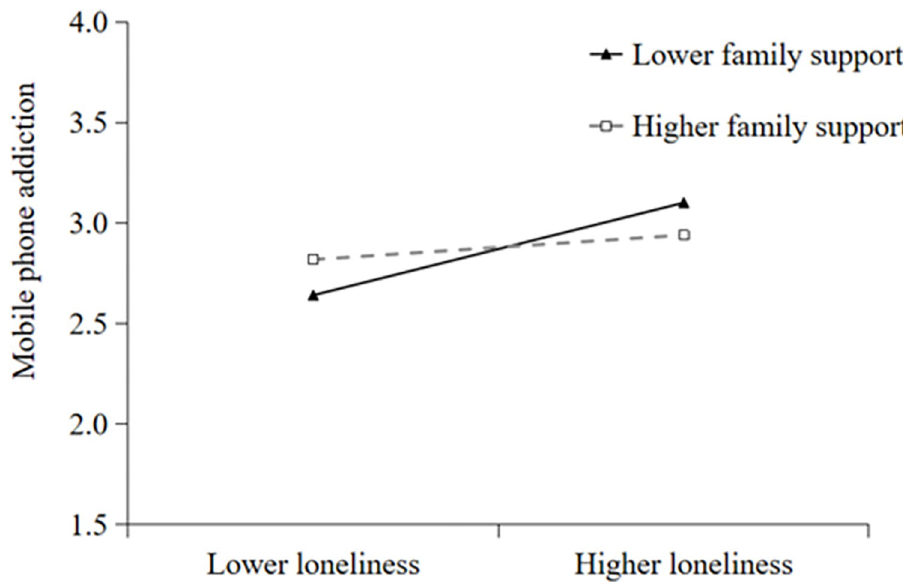
Fig 2. Family support moderates the relation between loneliness and mobile phone addiction.